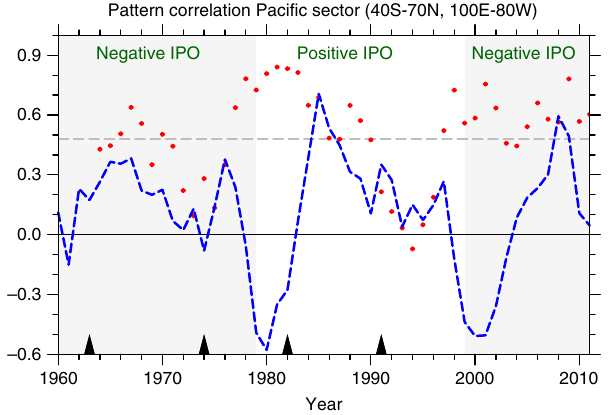
Figure 2 | Hindcast skill for the IPO. Anomaly pattern correlation for the Pacific SSTs in hindcasts initialized every year from 1960 for CCSM4 (ocean points only, 40 (cid:2) S–70 (cid:2) N, 100 (cid:2) E–80 (cid:2) W; same as in Fig. 2e in ref. 4, but just for CCSM4 see Methods). Horizontal dashed line is 95% significance. Blue dashed line is persistence prediction defined as the average of years three to seven in the future having the same SSTanomalies as the 5-year average before the start of the prediction. Each red dot represents the central year of the 3- to 7-year average hindcast; thus, the value for the initial year 1960 for the prediction averaged for 1962–66 is plotted for 1964 and so on. Phase changes of the IPO from negative to positive in the late 1970s and from positive to negative in the late 1990s are denoted by shading. Hindcast skill notably drops below 95% when influenced by the volcanic eruptions (denoted by triangles above x axis) of Fuego in the early 1970s and Pinatubo in the early 1990s, but not Agung in the early 1960s or El Chichon in the early 1980s 23